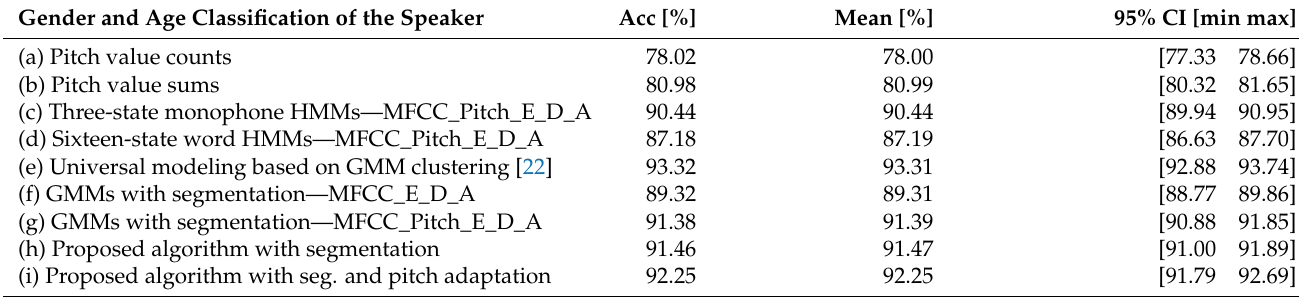
Table 2. Accuracy results obtained by gender and age classification of the speaker and statistical analysis of the results with a 95% confidence interval.